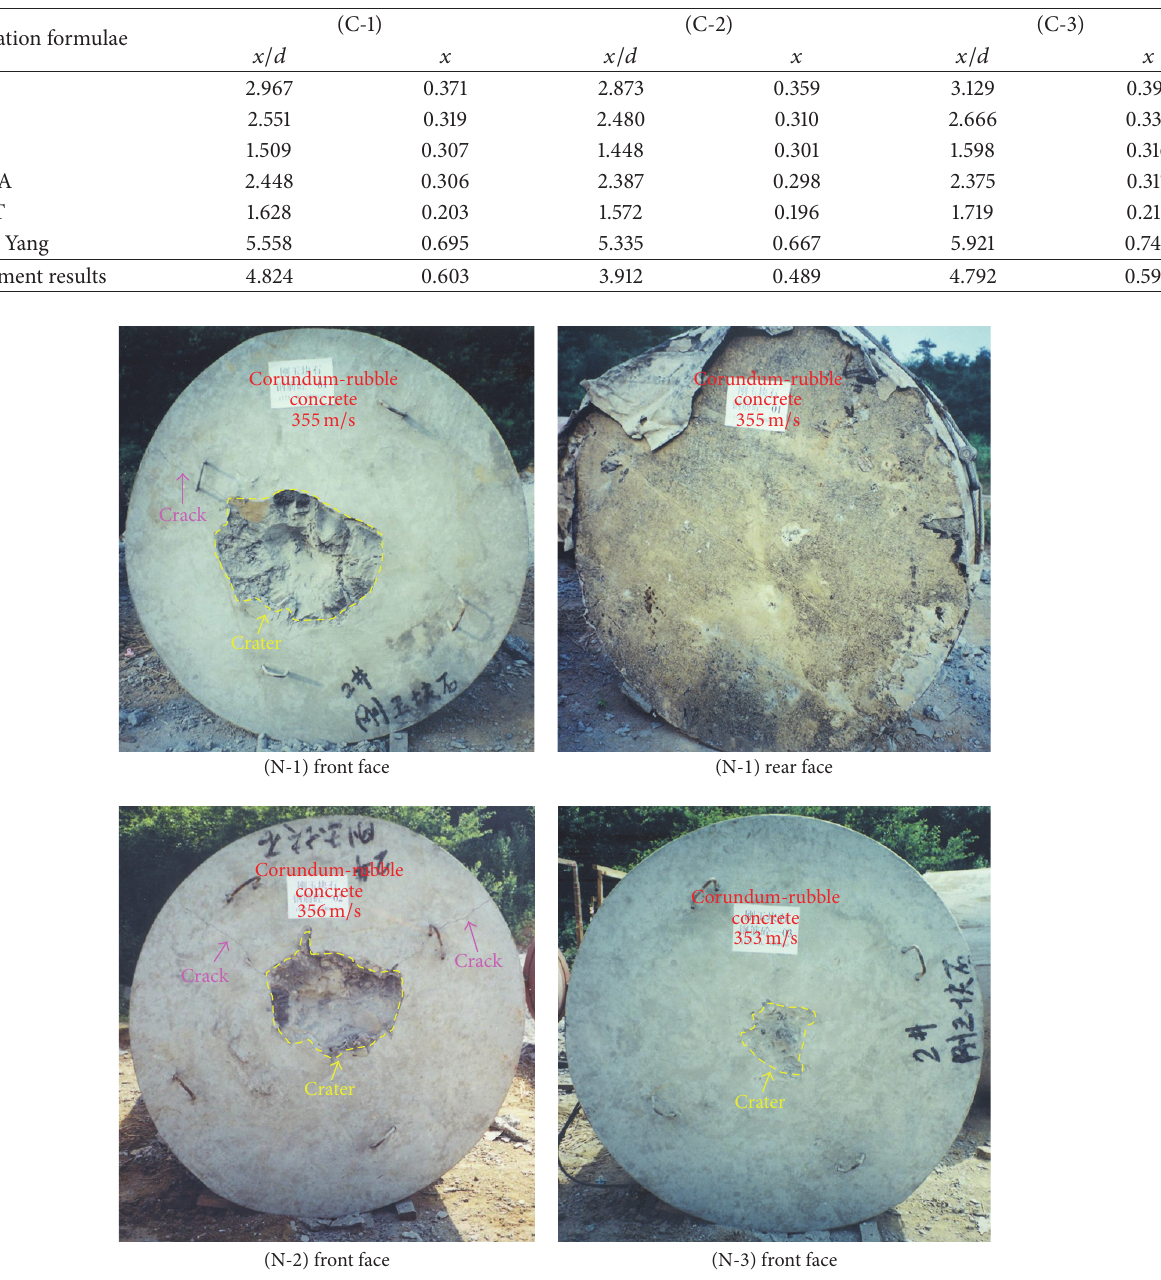
Figure 9: Damage of CRC